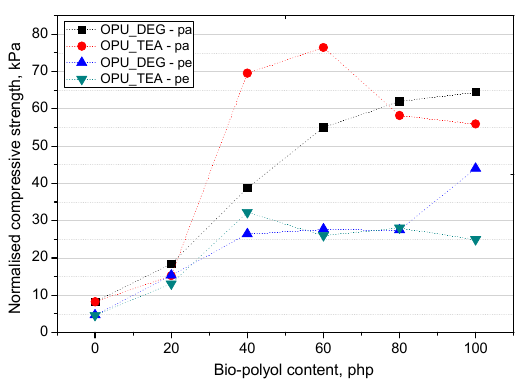
Figure 8. Normalized compression strength of PUR foams.